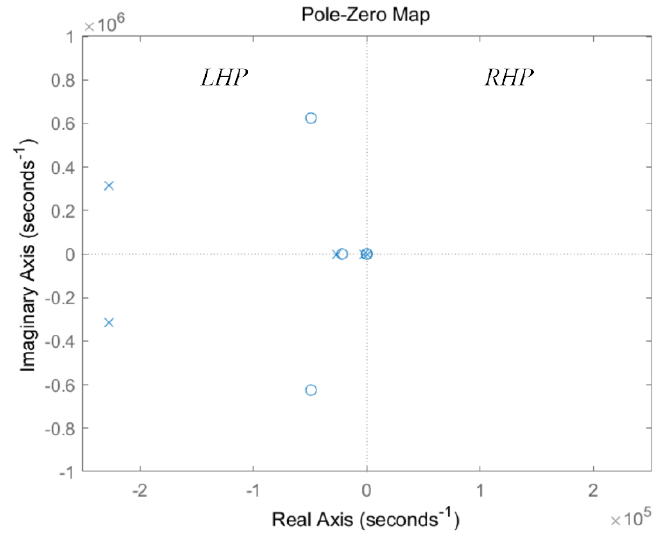
Figure 5. Poles and zeros of the transfer function H ( s ) on complex plane.